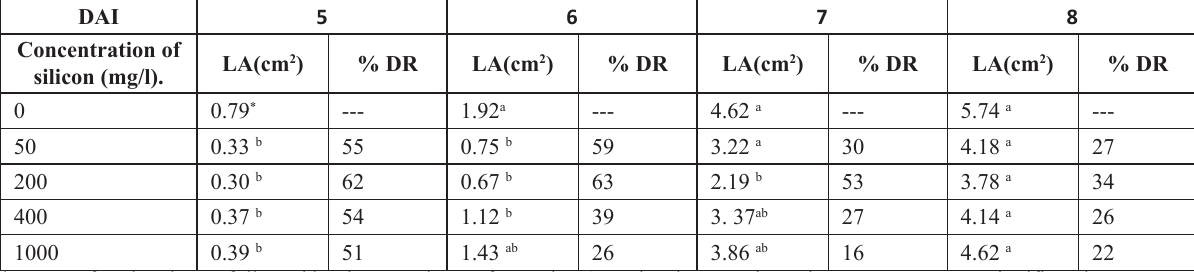
Table 1: Effect of postharvest treatment of potassium silicate (Kasil ® ) on the anthracnose development in C.annuum cv. HYW. DAI 5 Concentration of silicon (mg/l).